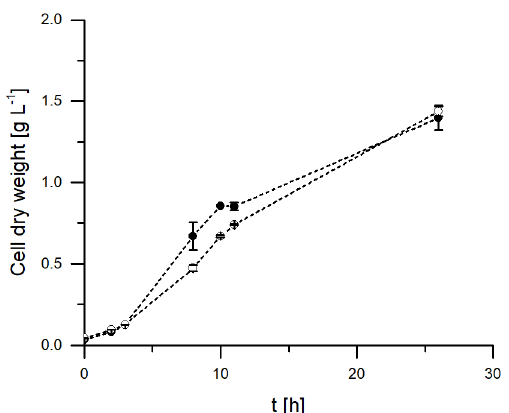
Figure A1. Two-liquid phase shake flask fermentations with E. coli BL21 (DE3) pJBEI-6410 in M9 minimal medium with either 0.5% w / v glucose (closed symbols, ● ) or glycerol (open symbols, ○ ) as the sole carbon source. Cell dry weights were determined at regular intervals. The error bars relate to biological duplicates.